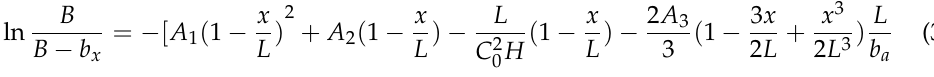
Figure 17. Schematic diagram of the influence of Groin B on the backflow behind Groin A in different cases, ( a ) Groin B in the upstream far-field of Groin A, ( b ) Groin B in the upstream near-field of Groin A, ( c ) Groin B in the downstream near- field of Groin A, ( d ) Groin B in the downstream far-field of Groin A.